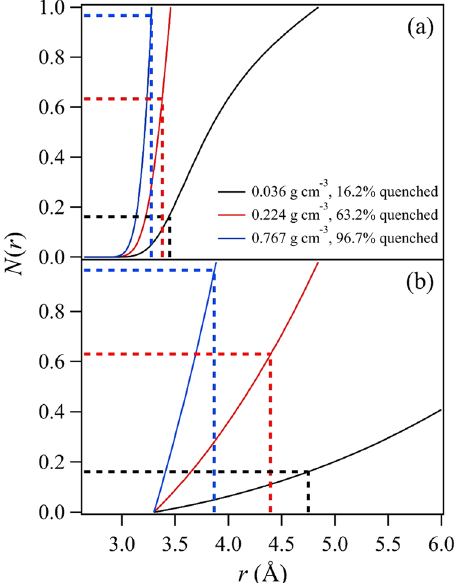
Fig. 7 Running coordination number for CO 2 dimers. The running coordination number is shown as a function of carbon – carbon distance at the lowest experimental density (0.036 g cm − 3 ) and highest density (0.767 g cm − 3 ) measured, as well as at 0.224 g cm − 3 , the density associated with 1/ e of the vibrational structure inherent to the spectrum remaining. Horizontal lines indicate the fraction of vibrational structure quenched at a particular density and vertical lines indicate the associated critical radius. a Data for the slipped parallel 60° geometry and b data for a hard sphere treatment.